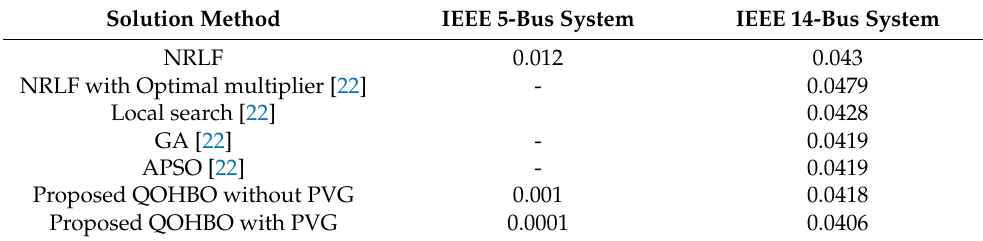
Table 5. Line reactance multiplier for the critical